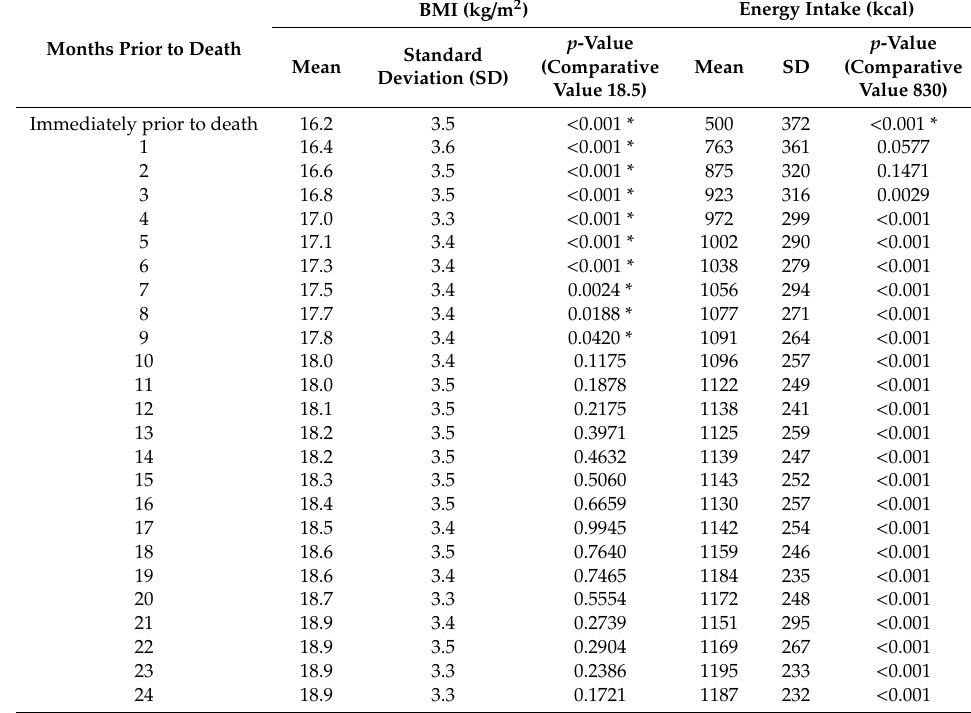
Table 2. A comparison of values and significant di ff erences for each parameter from 24 months prior to death until the time immediately prior to death.